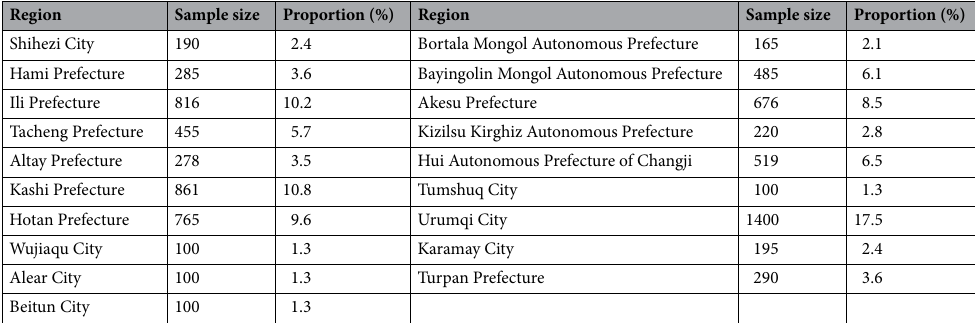
Table 1. The number of samples and their distribution. Data source: The Statistics Information Reference Center of Xinjiang